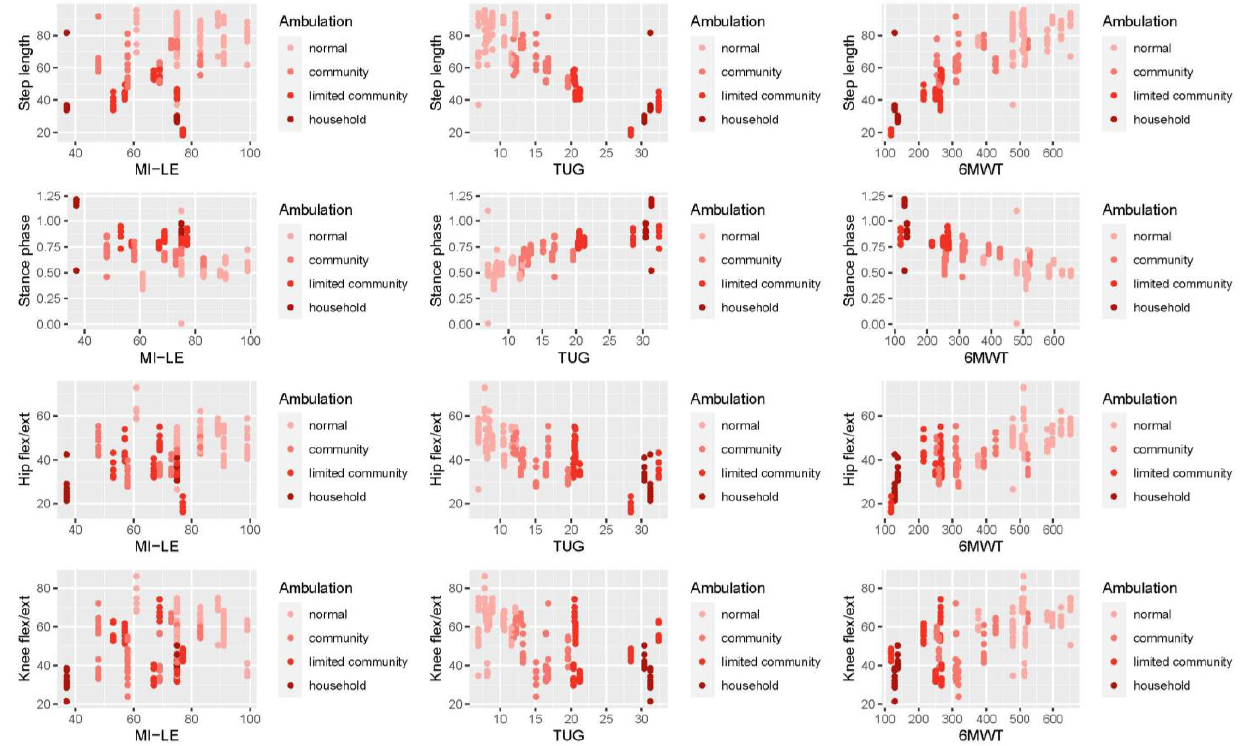
Figure 4. Relationships between clinical, kinematic gait metrics (step length, stance phase, and hip and knee flexion/extension) and ambulatory deficits (normal, community, and limited community or household ambulation). MI-LE, motricity index of the lower extremity; TUG, timed up and go test; 6MWT, six minute walk test.